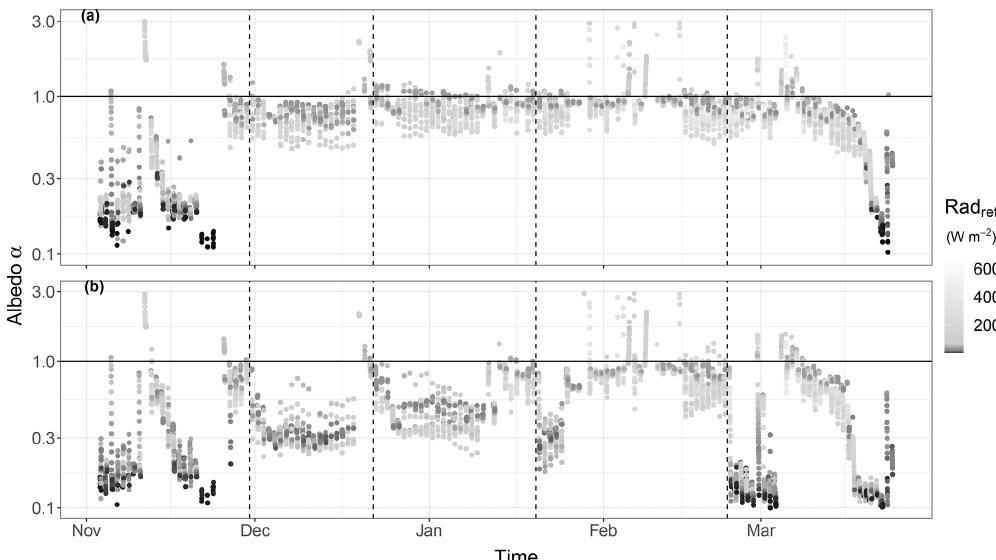
Figure 7. Plots of albedo α (in logarithmic scale), calculated as a ratio of reflected and incident radiation, for the (a) snow-covered and (b) snow-cleared sites. The horizontal black lines represent the theoretical maximum value of albedo ( α = 1), while vertical dashed lines mark the snow removal events. Data points are coded in greyscale as a function of reflected radiation, with a 35Wm − 2 threshold on global radiation to exclude outliers measured below the uncertainty of the instrument.